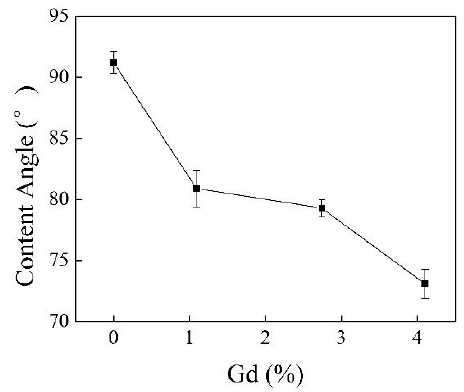
Figure 10. Contact angles of iPB-1 and iPB-g-MAH samples with different Gd.